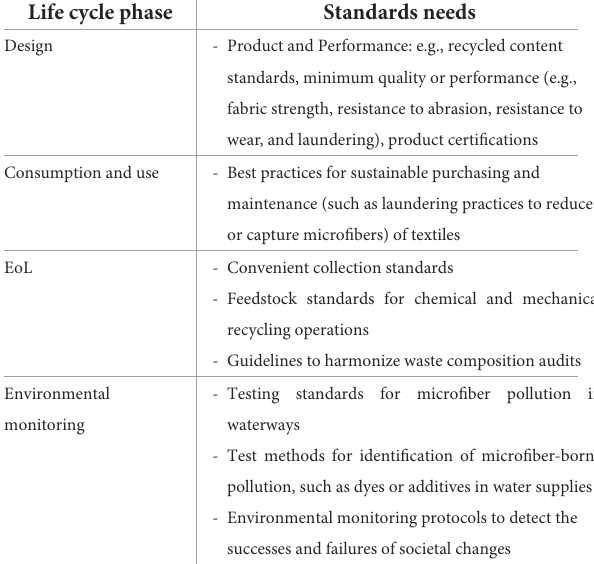
TABLE 7 Standards needs to facilitate a CE for